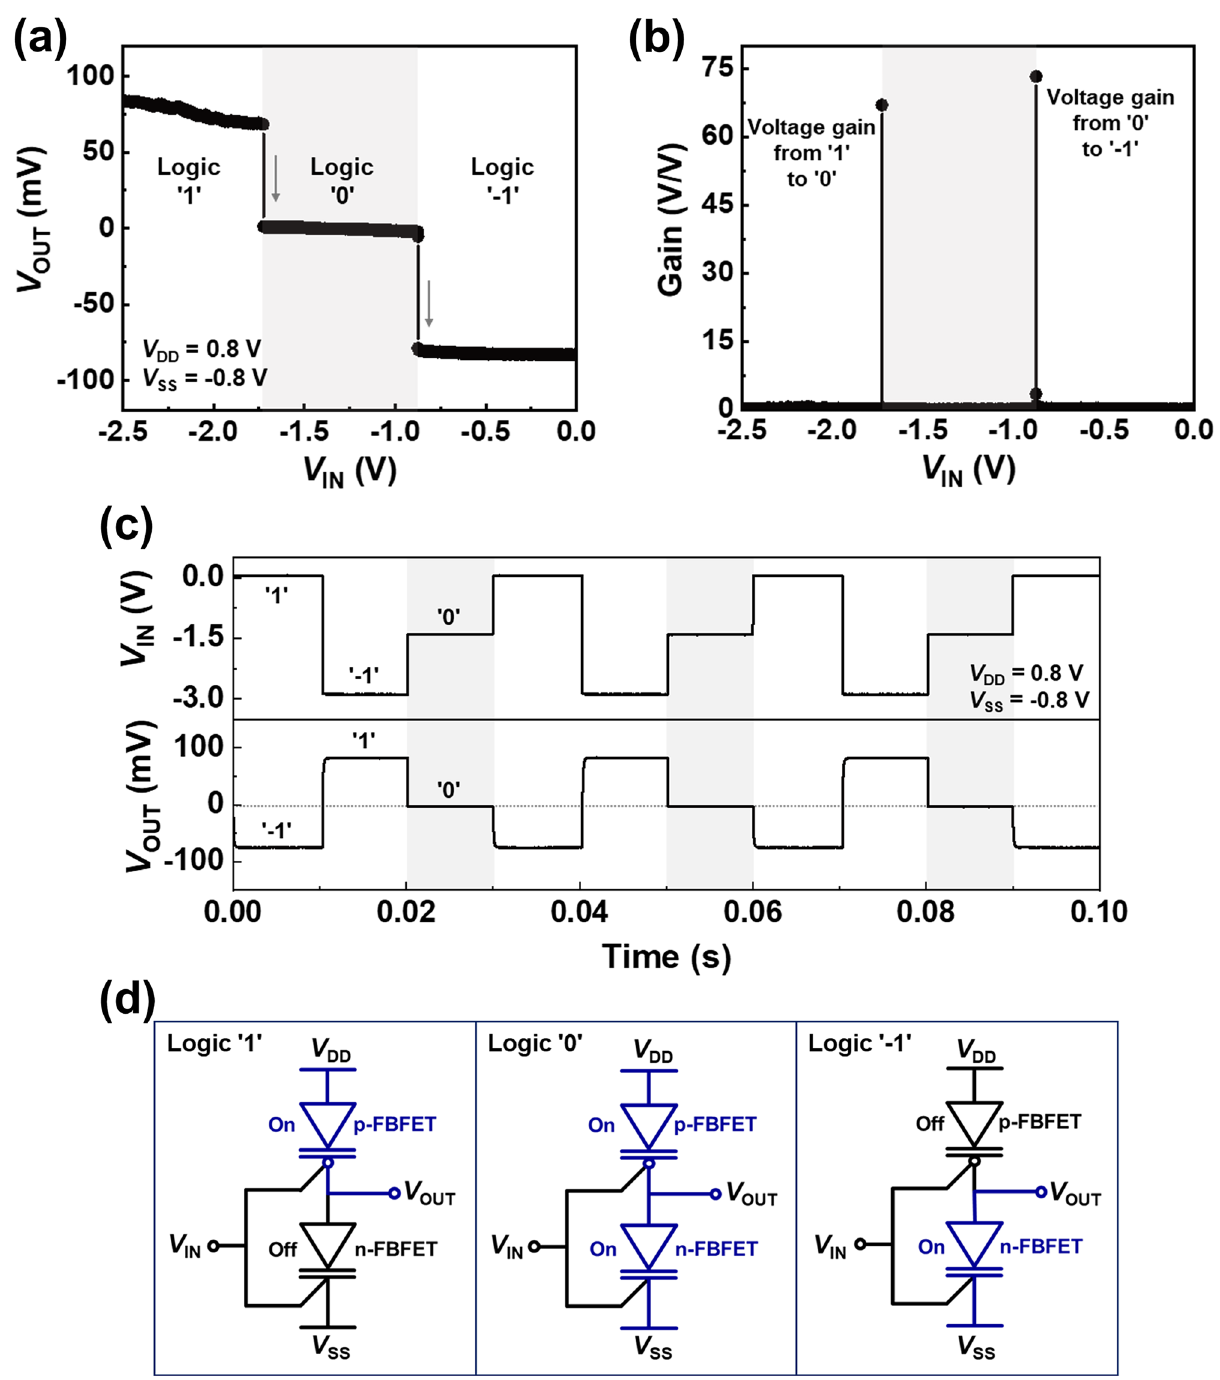
Figure 3. ( a ) Voltage transfer characteristics of a ternary inverter, and ( b ) corresponding voltage gains. ( c ) Logic operation (‘1’, ‘0’, and ‘− 1’) under dynamic condition. ( d ) Schematic for logic ‘1’, ‘0’, and ‘− 1’